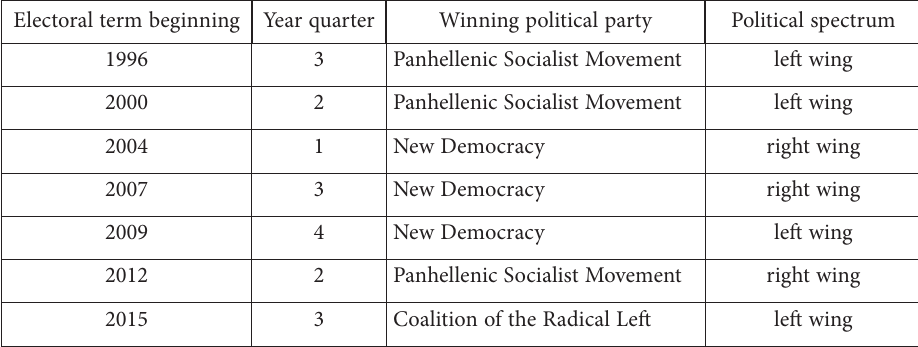
Table 1. Overview of the election results from 1996 to 2015 (source: own elaboration by the authors according to Norsk senter for forskningsdata) Electoral term beginning Year